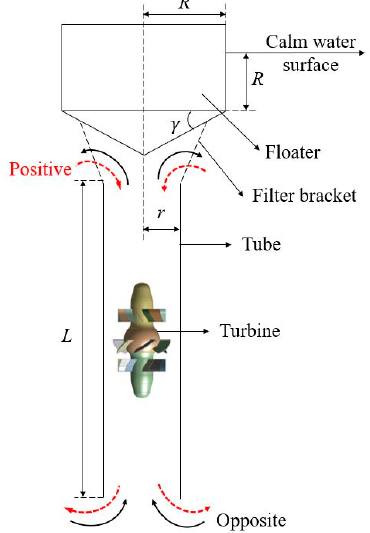
Figure 1. Structural parameters and working principle of the wave-energy converter (WEC).